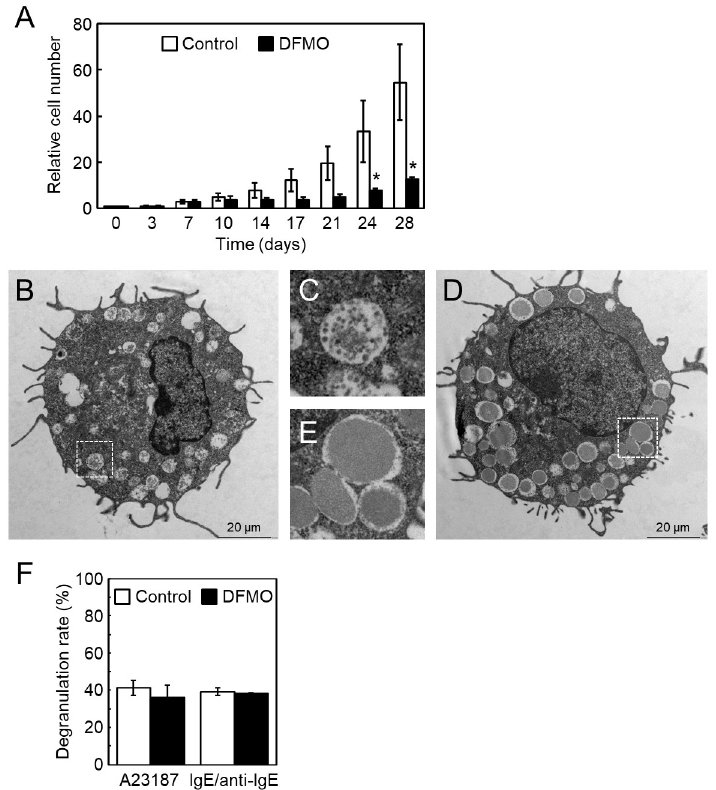
Fig 1. Cell number and morphology of BMMCs in the absence or presence of DFMO. (A) Starting with 0.1 mM DFMO treatment from day 3, the cells were cultured until day 28. The relative cell number on day 0 is shown as 1. Standard deviation (s.d.) was calculated; n = 3 replicates. � p < 0.05 compared with control. (B) Control and (D) DFMO-treated cells on day 28, observed with transmission electron microscopy. (C) and (E) Boxes with white dots from (B) and (D) in larger magnification, respectively. (F) β -hexosaminidase activity of supernatant and cell pellet after degranulation stimuli (calcium ionophore A23187 or IgE/anti-IgE) was given on day 28. Degranulation rate (%) ± s.d. is shown as [supernatant]/[supernatant + cell pellet], n = 3